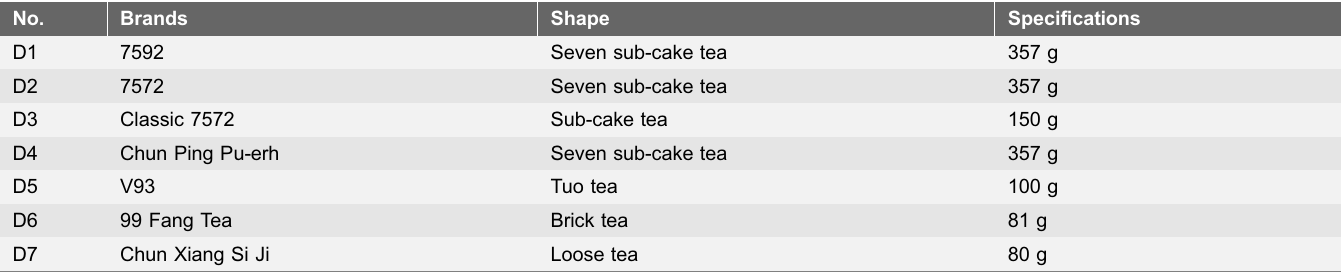
Table 1. Seven different brands of Dayi Pu-erh tea